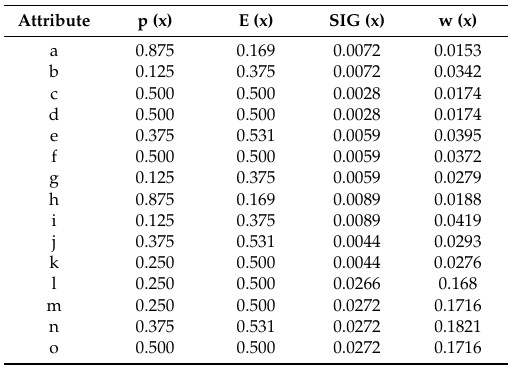
Table 6. Attribute weight value of the formal